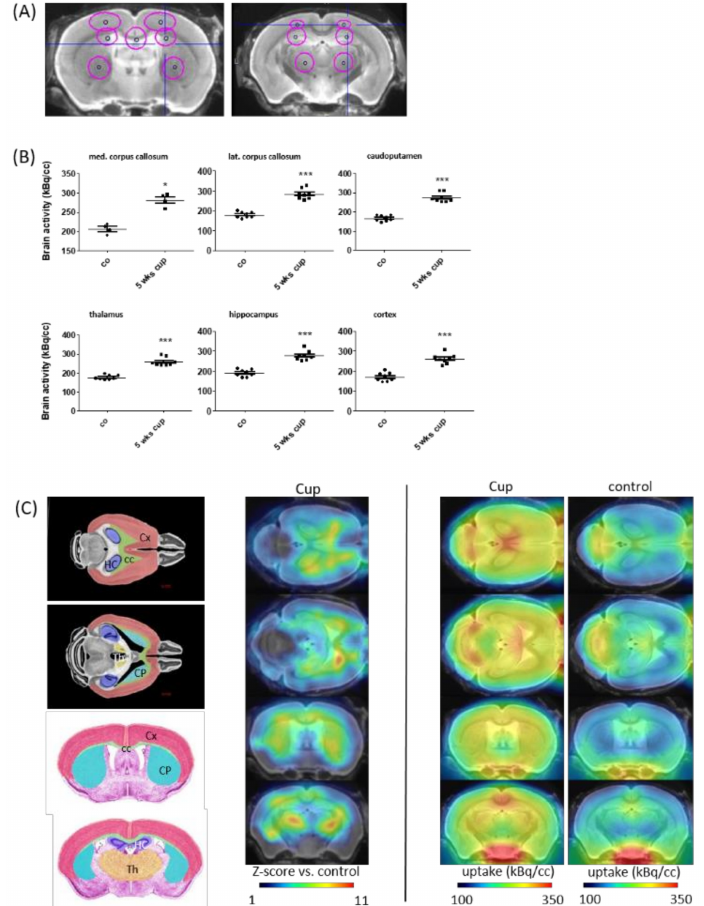
Figure 2. In vivo imaging demonstrates an increase in [18F]-GE180 uptake after cuprizone-intoxication. ( A ) The definition of VOIs (volumes of interest), demonstrated in a mouse brain MRI atlas in the coronal slides: medial corpus callosum (2.2 mm 3 ), lateral corpus callosum (2.9 mm 3 ), caudoputamen (4.4 mm 3 ), thalamus (4.4 mm 3 ), hippocampus (4.4 mm 3 ), and cortex (6.7 mm 3 ). ( B ) The quantification of radioligand uptake in the control animals ( n = 4) and after a 5-week cuprizone intoxication period ( n = 4). ( C ) Schematic illustration of the measured areas and cumulative heat map illustrating radioligand uptake in cuprizone-treated mice. The color codes demonstrate the standardized radioligand uptake levels relative to the controls (Z-scores; left column), and the normalized uptake in cuprizone-treated (middle column) and control (right column) mice. Cx (cortex); CC (corpus callosum); HC (hippocampus); Th (thalamus); CP (caudoputamen). Differences were determined using Mann–Whitney tests. * p < 0.05, ** p < 0.01, and *** p <